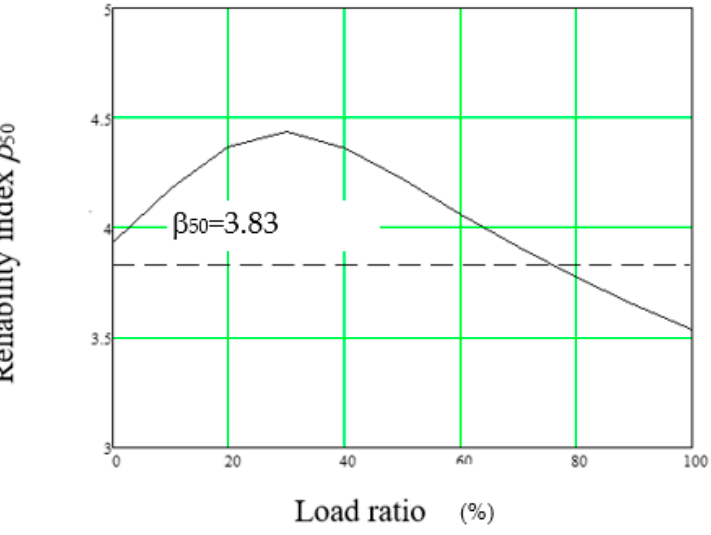
Figure 3. The reliability index calculated for V M = 0.15, γ M = 1.15. The horizontal dashed line denotes the target reliability index β 50 = 3.83.